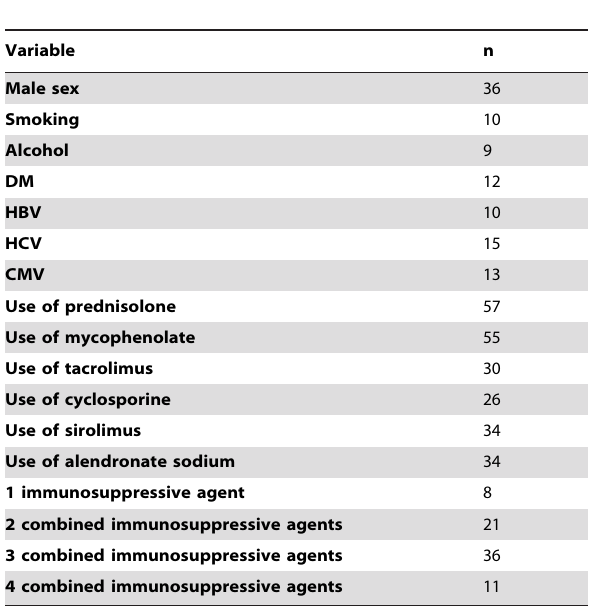
Abbreviations: n, number of patients; CMV, cytomegalovirus; DM, diabetes mellitus; HBV, hepatitis B virus; HCV, hepatitis C virus.